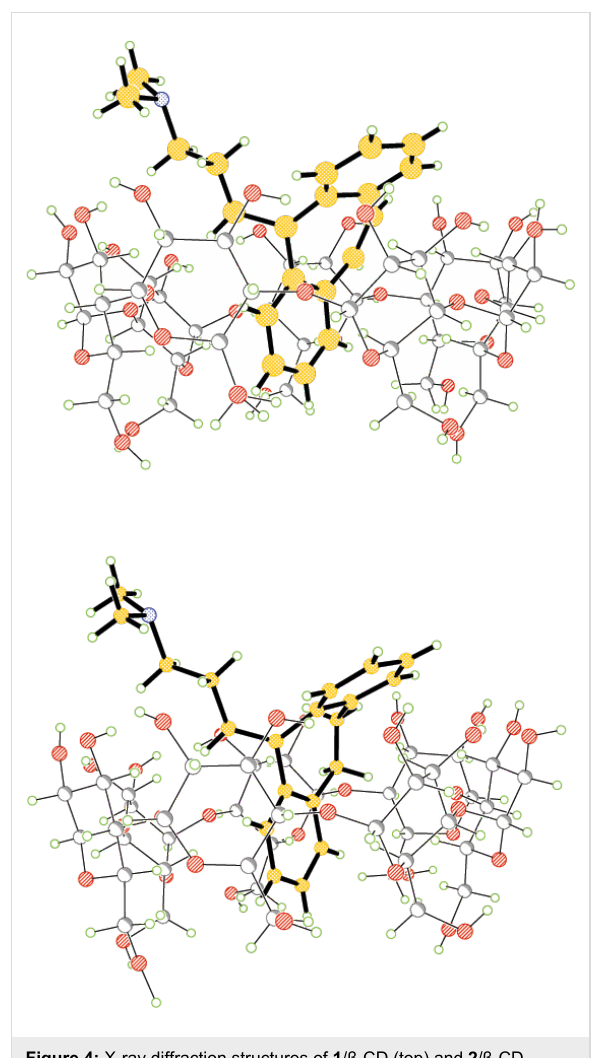
Figure 4: X-ray diffraction structures of 1 / β -CD (top) and 2 / β -CD (bottom) complexes.